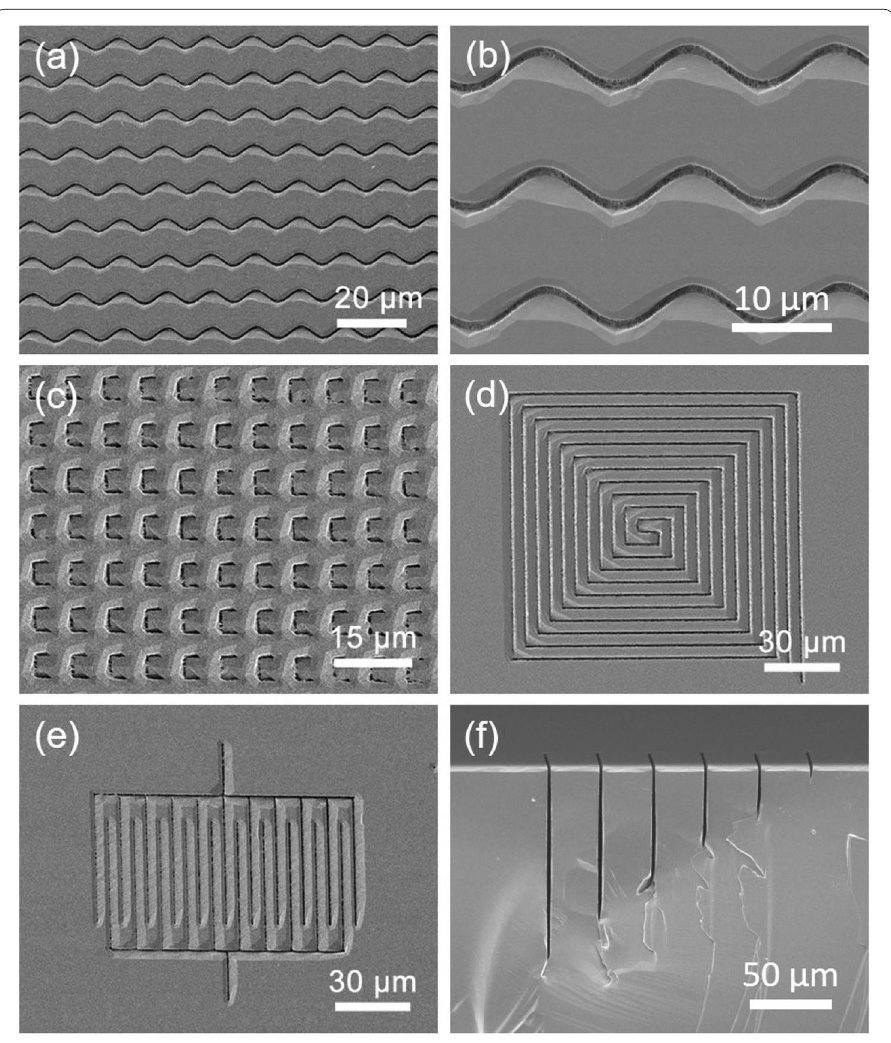
Fig. 3 SEM images of various microstructures fabricated by introducing the sacrificial layer. a Wave lines arrays, b Magnified region of the wave lines, c Square and split rings arrays, d Square coil, e Interdigital structure. f Profile SEM image of microstructures with different